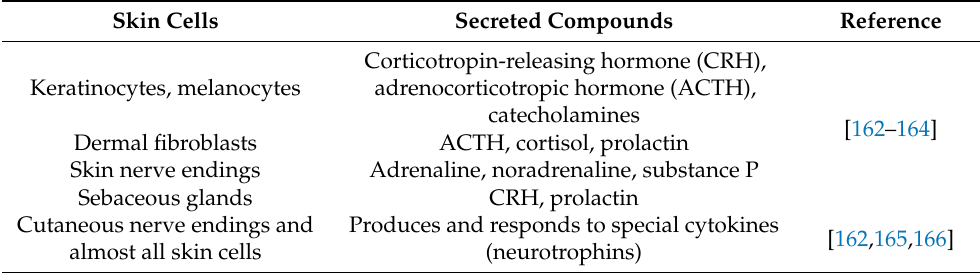
Table 4. Anti-inflammatory secreted signals of the different skin layers. Skin Cells Secreted